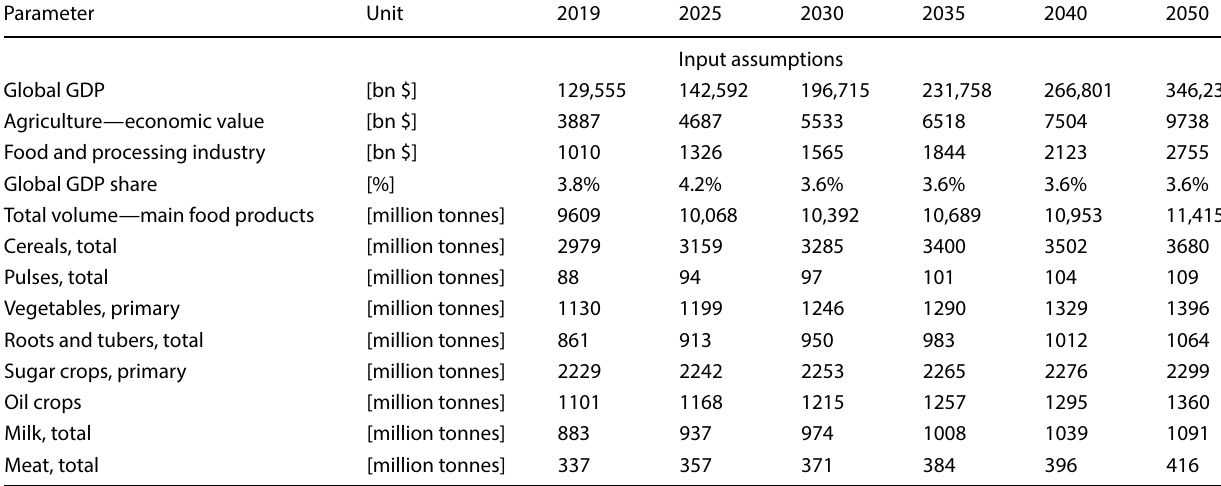
Table 4 Input—Economic development—agriculture and food processing: 2019 and projections towards 2050. Source : Food and Agricul- ture Organisation of the United Nations (FAOSTAT: Production)